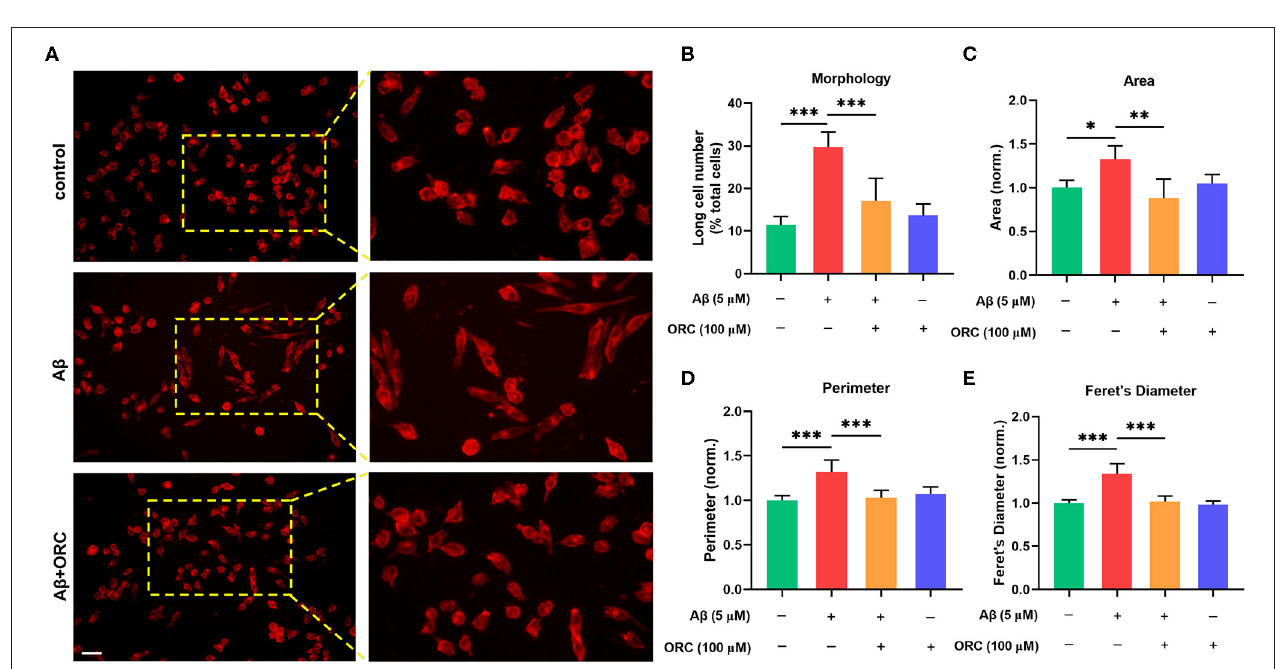
FIGURE 2 | Oxiracetam (ORC) inhibits morphological changes induced by A β . The morphological changes in BV2 cells were assessed using ActinRed, and the “short” and “long” morphological phenotypes within BV2 cell populations were observed. Scale bar: 50 µ m (A) . Stimulation with A β led to an increased ratio of cells with the “long” phenotype. ORC attenuated this change (B) . ORC modulated A β -induced BV2 cell morphological alterations in terms of cell area (C) , perimeter (D) , and Feret’s diameter (E) . * p < 0.05, ** p < 0.01, and *** p < 0.001.